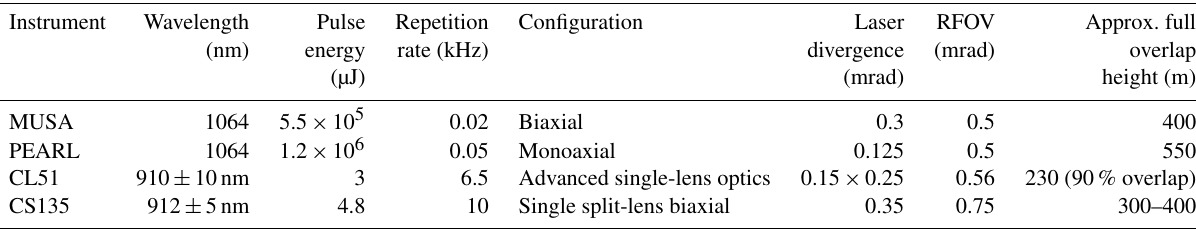
Table 2. Specifications of MUSA and PEARL at 1064nm, CL51 and CS135. All the instruments are operated in the zenith-pointing mode. RFOV indicates the half-angle rectangular field of view of the instruments. Instrument